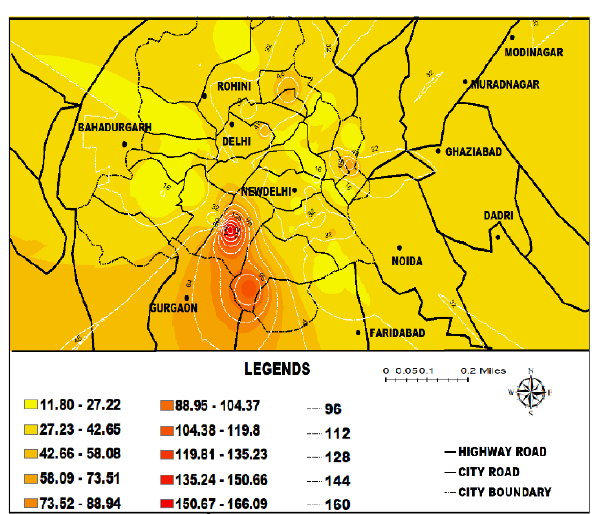
Figure 8. Air quality map of Delhi August monthly average based on NOx (µg/m 3 ).